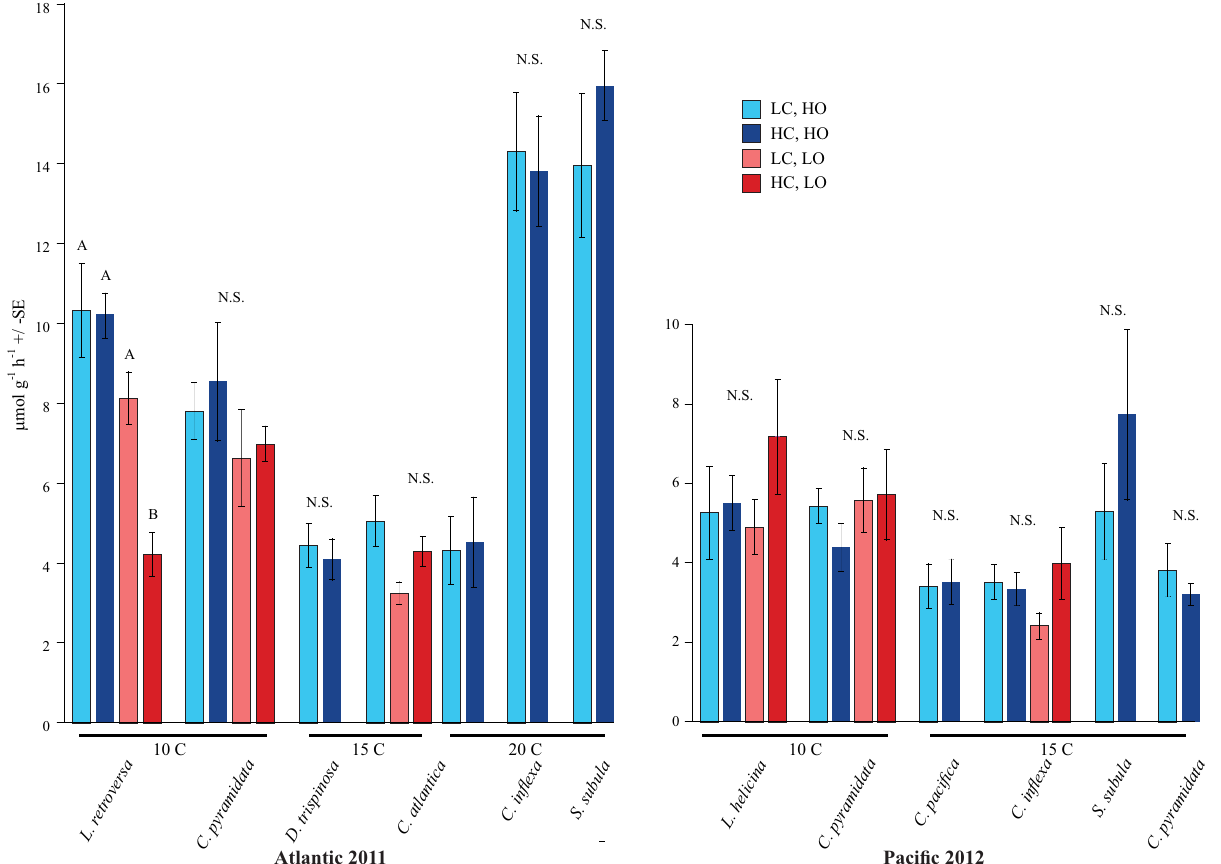
Figure 3. Thecosome respirometry. Mean metabolic rate and standard error (µmolO 2 g − 1 h − 1 ) of thecosomes exposed to low (i.e., ambient) CO 2 and normal O 2 (light blue; LC/HO), high CO 2 and normal O 2 (dark blue; HC/HO), low CO 2 and low O 2 (light red; LC/LO), or high CO 2 and low O 2 (dark red; HC/LO). The species and temperature of the experiment are reported below the x axis. Significance is reported based on a basin, species, and temperature-specific GLM, which tested for the effect of treatment on O 2 consumption with a Bonferroni post hoc analysis (Table 5). In the Atlantic analysis each treatment was tested independently, while in the Pacific CO 2 and O 2 were treated as factors. For each species and temperature, treatments are reported as non-significant (N.S.) or, in the case of significance, by letters that indicate which treatments are statistically similar (same letter) or different (different letter) at a p value<0.05. Note that for C. atlantica the metabolic rates of individuals respired at 20 ◦ C were converted to 15 ◦ C using a temperature coefficient of 2 (see methods) for this GLM